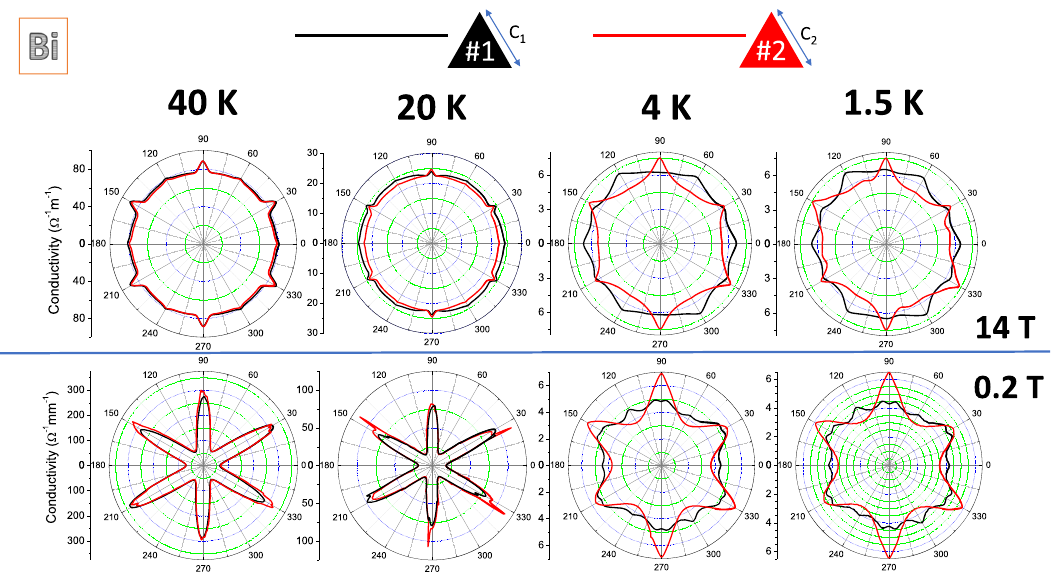
Fig. 3 The emergence of shape dependence with cooling. The evolution of angle-dependent magnetoresistance with cooling for B = 14 T (top panels) and for B = 0.2 T (bottom panels). Note the emergence of a difference at low temperatures in both